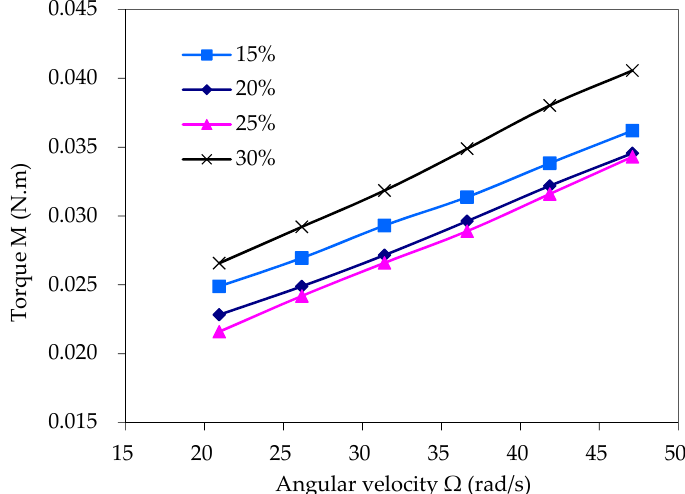
Figure 5. M − Ω curve of the slurry with concentrations of 76%–79% (Group A). Figure 5. (cid:1839) − Ω curve of the slurry with concentrations of 76%–79% (Group A).